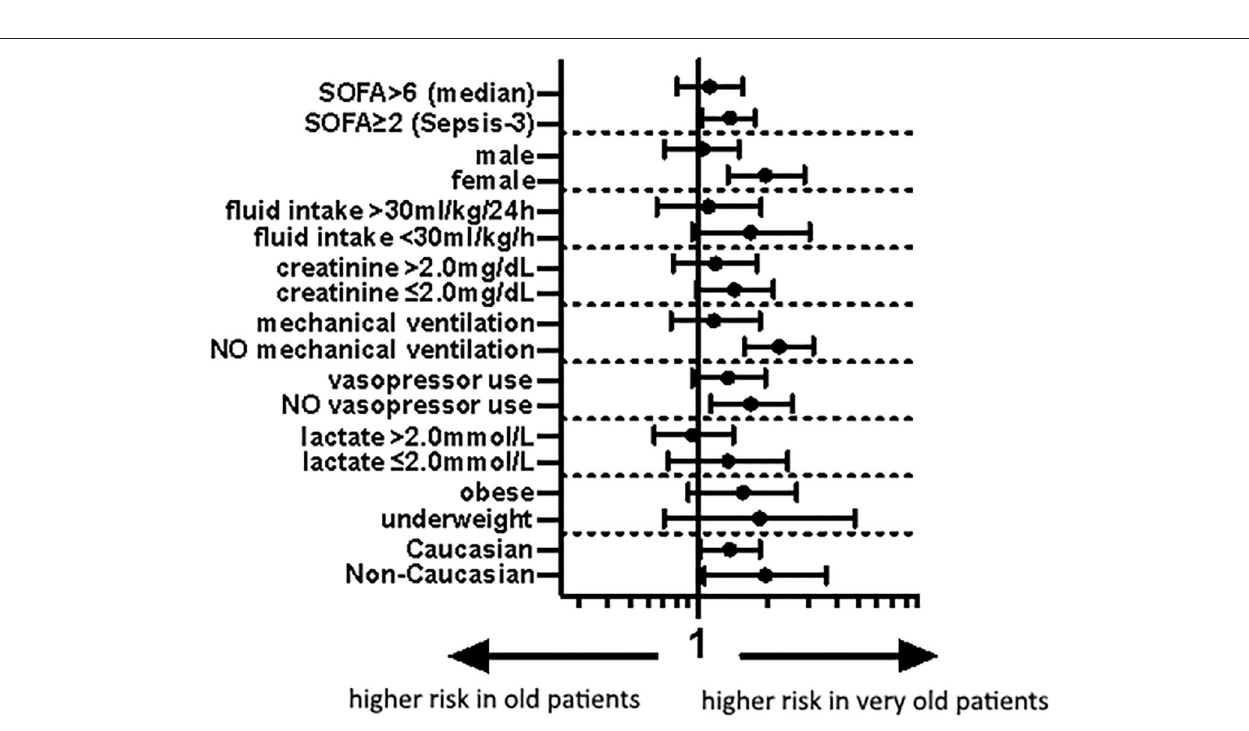
FIGURE 3 | Forest plot of aOR of old vs. very old septic patients for different subgroups according to model-1 (aOR 95% CI). SOFA, Sepsis-related organ failure assessment. considerable costs of an intensive care stay with an associated high mortality on the one hand and the high morbidity among the survivors on the other, are understandable and necessary